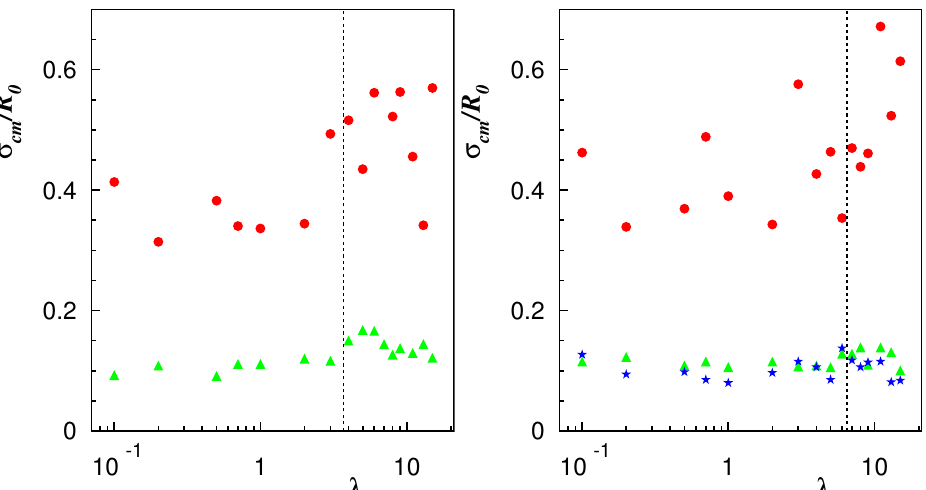
Figure 10. Rms fluctuation values σ cm of the vertical position of the vesicle center of mass of Figure 9 as a function of λ at S ∗ = 0.80 ( left ) and S ∗ = 0.95 ( right ) for κ / ( k B TR 0 ) = 6.58 ( • ), 65.8 ( (cid:78) ), 164.5 ( (cid:63) ). The tank-treading to tumbling transition in the Keller–Skalak theory [5] is marked by the dashed vertical